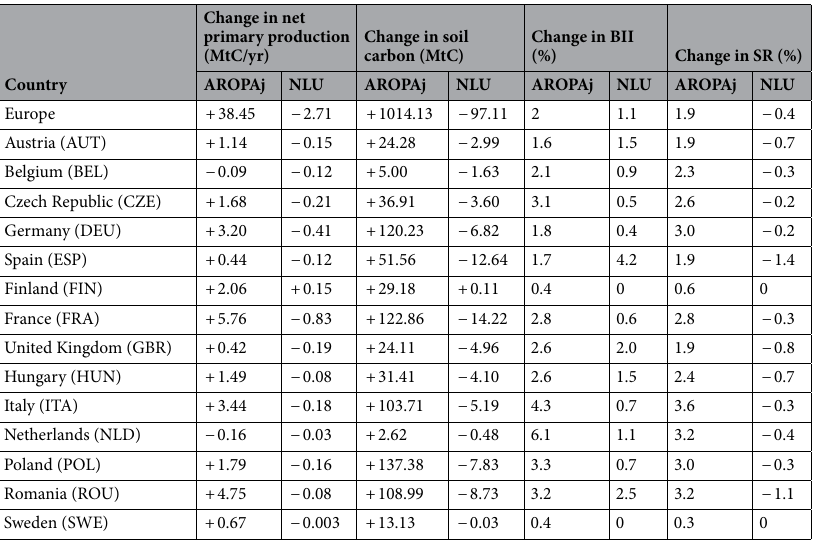
Table 3. Annual change in total Net Primary Production (MtC/yr), Soil carbon (MtC), BII (%) and SR (%) between Halving-N and Baseline simulations across the EU along with selected EU countries. The changes are computed from the last 50 years’ annual averages of the 150-year simulation.